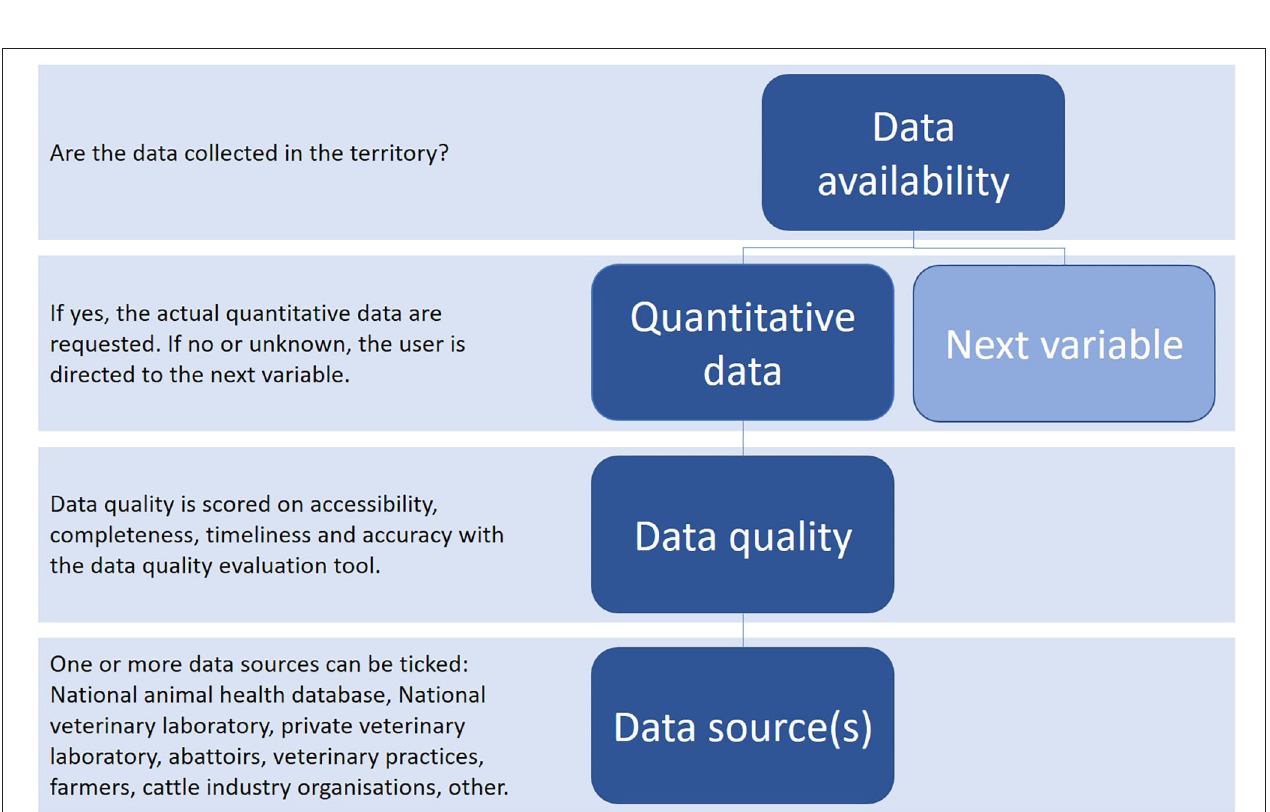
FIGURE 3 | Schematic overview of the question structure of the online data collection tool. For each variable within the data collection tool this structure is followed from top to bottom.